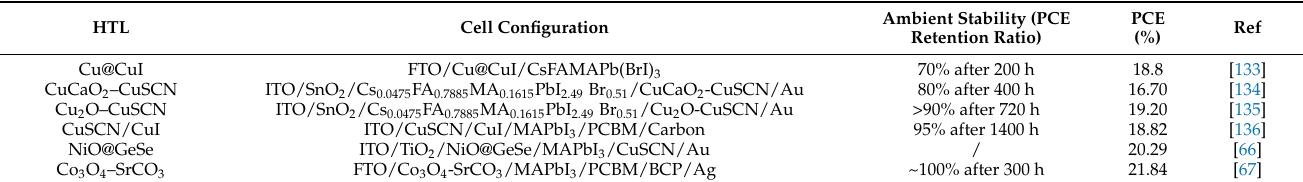
Table 3. Performance comparison of PSCs with typical nanocomposite inorganic HTLs.